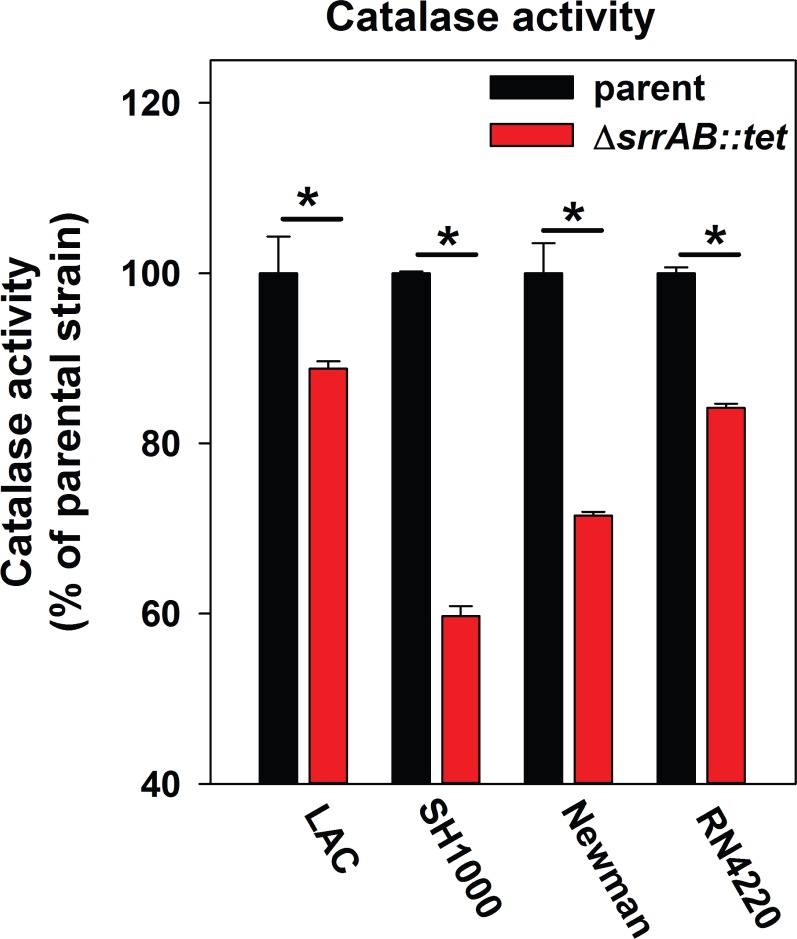
The influence of SrrAB upon aerobic respiration and H2O2 metabolism is conserved in diverse S. aureus isolates.Catalase (Kat) activity is decreased in diverse S. aureus isolates lacking SrrAB. The USA_300 LAC (JMB1100), USA300_LAC ΔsrrAB (JMB2047), Newman (JMB1422), Newman ΔsrrAB (JMB4751), SH1000 (JMB1323), SH1000 ΔsrrAB (JMB4556), RN4220 (JMB1103), RN4220 ΔsrrAB (JMB2030) strains were cultured aerobically to post-exponential growth phase and Kat activities were determined in the cell-free lysates. The data represent the average of biological triplicates with standard deviations shown.